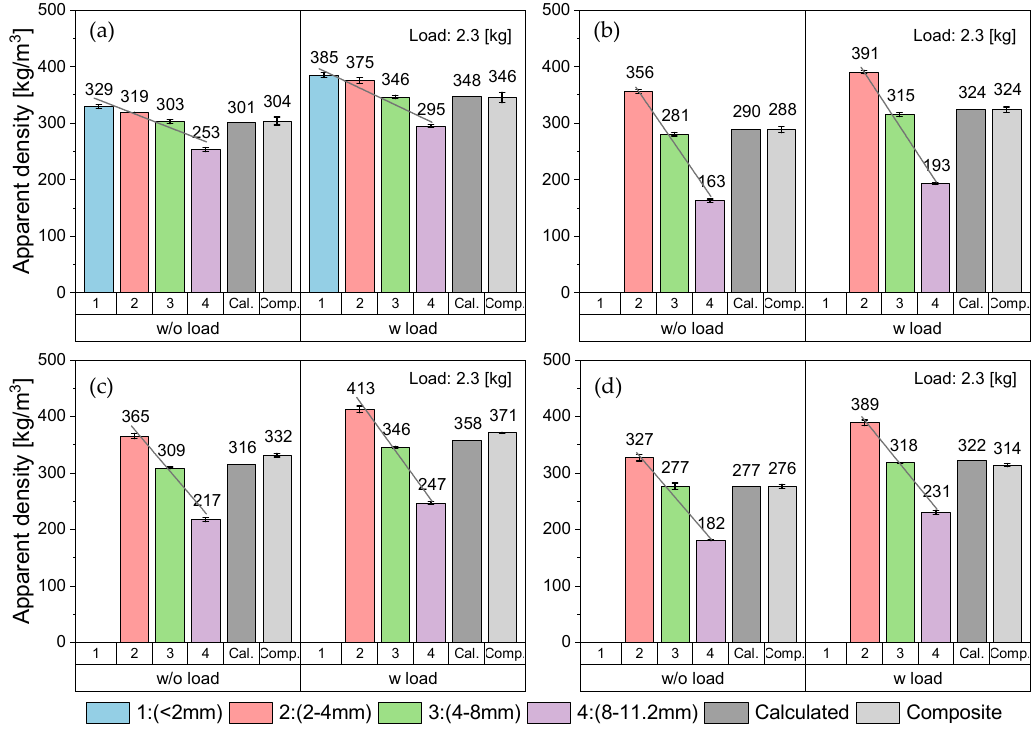
Figure 13. AD without and with weight load based on the test method from ASTM D1895 [82] of the various size fractions in comparison to the values of their corresponding calculated AD and composite samples ( a ) PP_1, ( b ) PP_2, ( c ) PE-HD_1, ( d ) PE-HD_2.